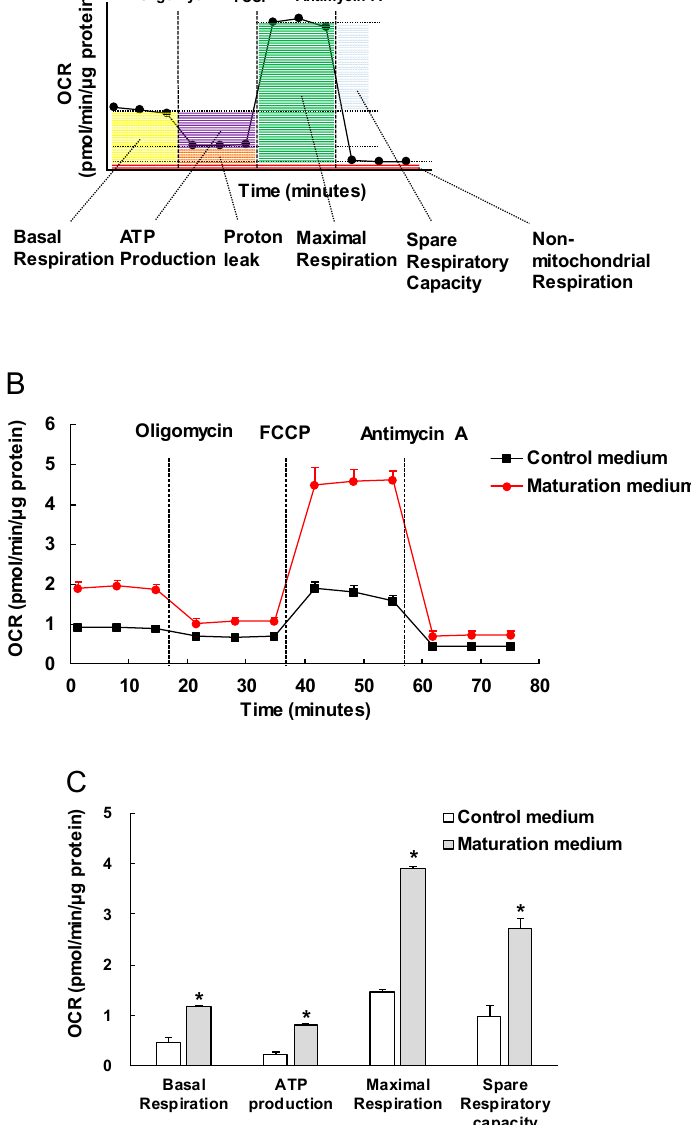
Figure 4. The e ff ect of maturation medium on mitochondrial respiratory capacity of 1013 iPSC-derived CMs. ( A ) The diagram depicts the trace of oxygen consumption rate (OCR) on cells after sequentially administration of 10 µ M oligomycin (ATP synthase inhibitor), 2 µ M FCCP (uncoupler of oxidative phosphorylation in mitochondria), and 10 µ M antimycin A (electron transport chain blocker) to the culture. The profiles of fundamental parameters of mitochondrial function measured are basal respiration, ATP production, maximal respiration and spare respiratory capacity that were marked with di ff erent color in the schematic. ( B ) Representative two OCR traces of iPSC-CMs (day 34) treated with either control medium or maturation medium for 3 days, respectively, in response to oligomycin, FCCP, and antimycin A. ( C ) OCR parameters representing mitochondrial function in maturation medium-treated iPSC-CMs were significantly higher. n = 4, * p < 0.05 vs. control medium.